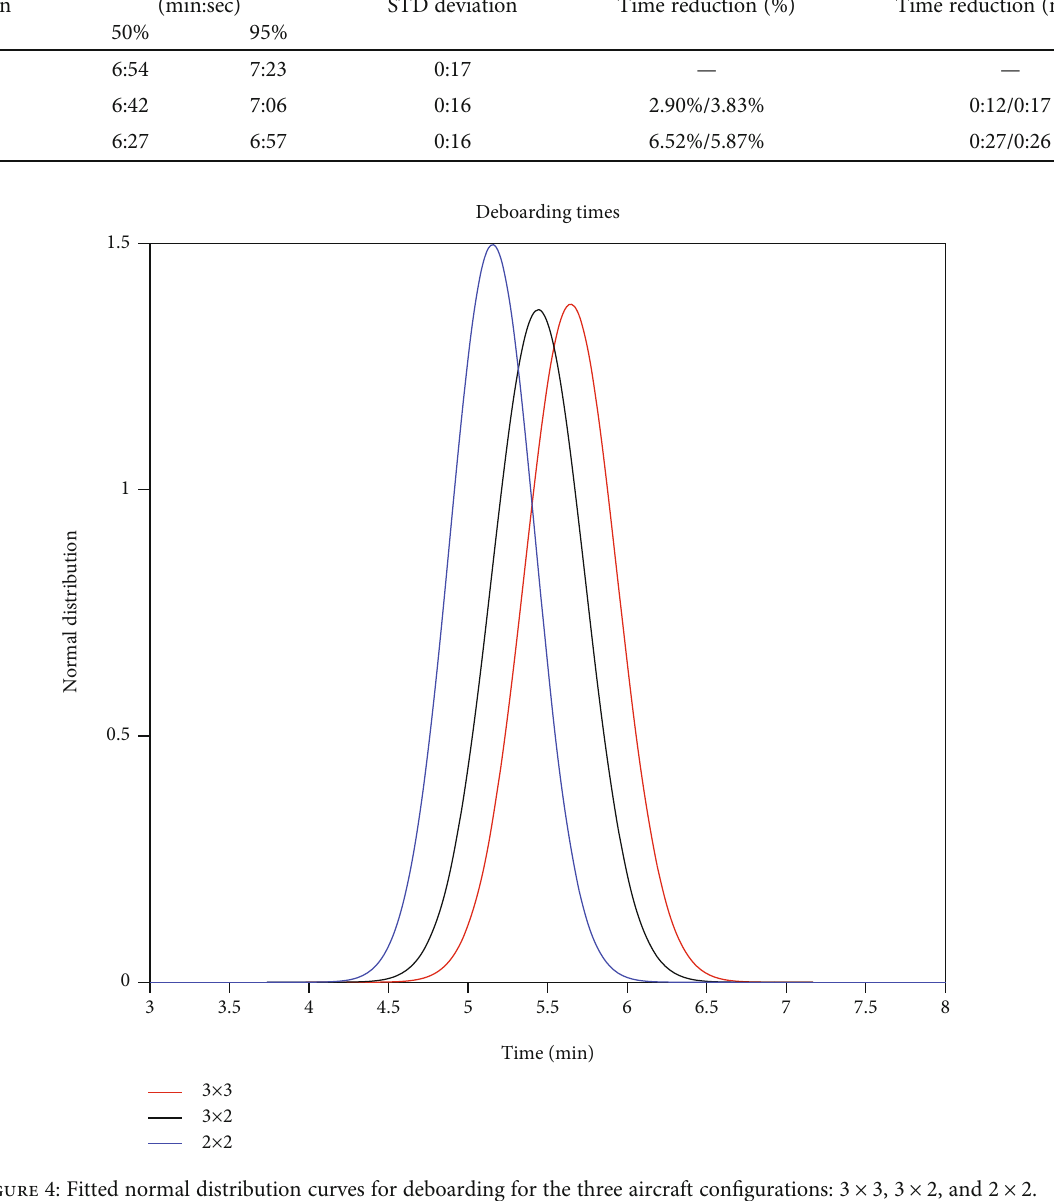
Table 3: Comparison of boarding times for the three aircraft con fi gurations using the random outside-in boarding strategy. Con fi guration